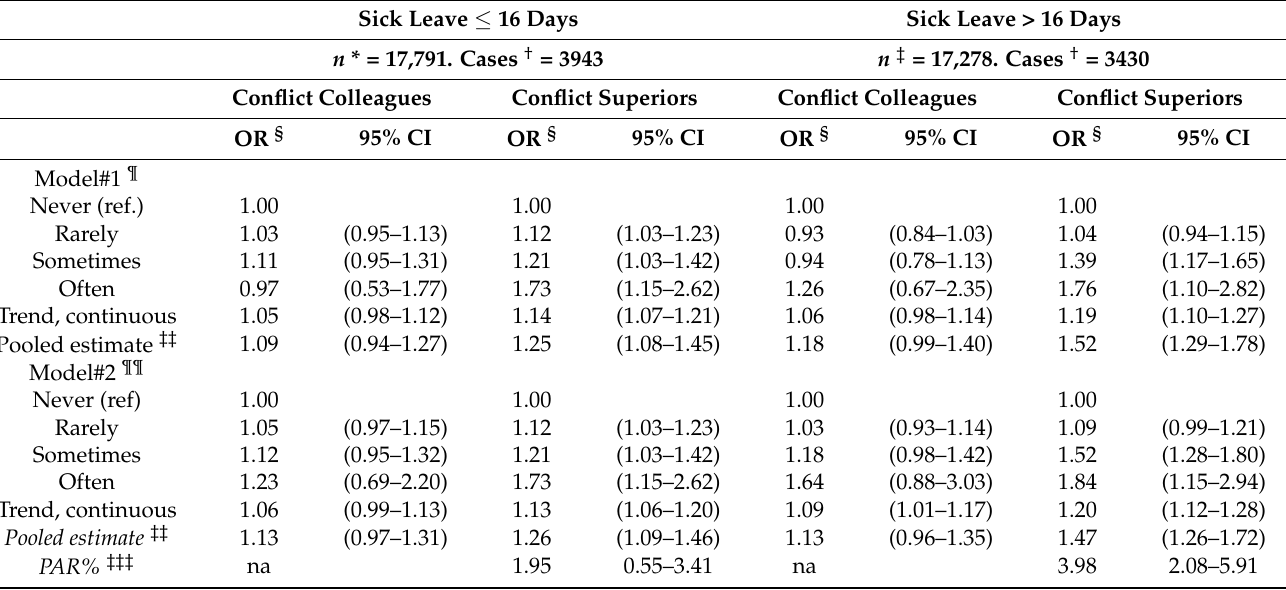
Table 3. Mixed-effects logistic regression: Sick leave regressed on workplace conflicts at baseline (LLSL = low level of sick leave; HLSL = high level of sick